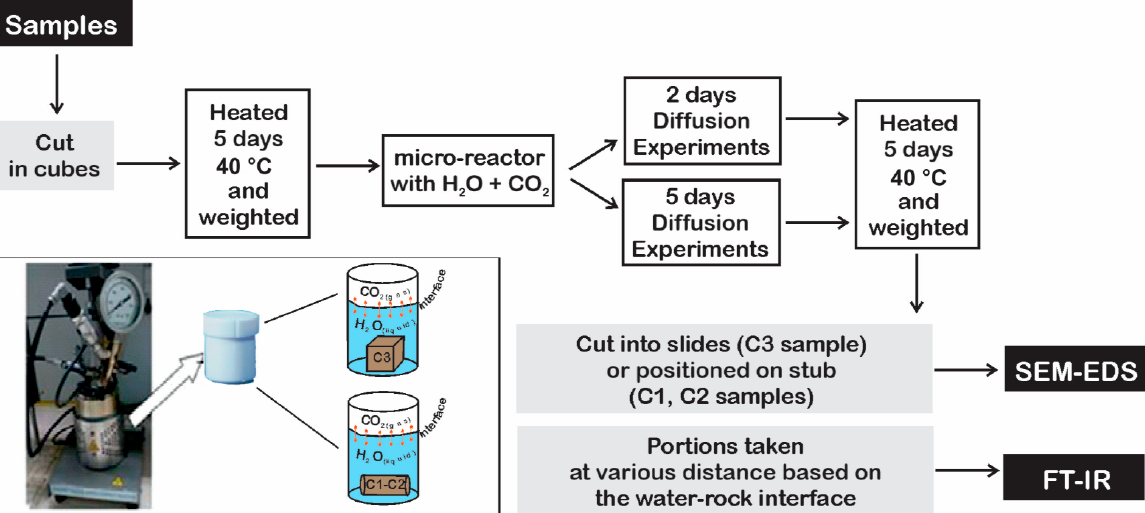
Figure 2. Workflow of diffusion experiments. Carbonate specimens were cut in cubes, whereas shales were cored in cylinders and hosted in a custom-made reaction vessel in high density polytetrafluoroethylene (PTFE).